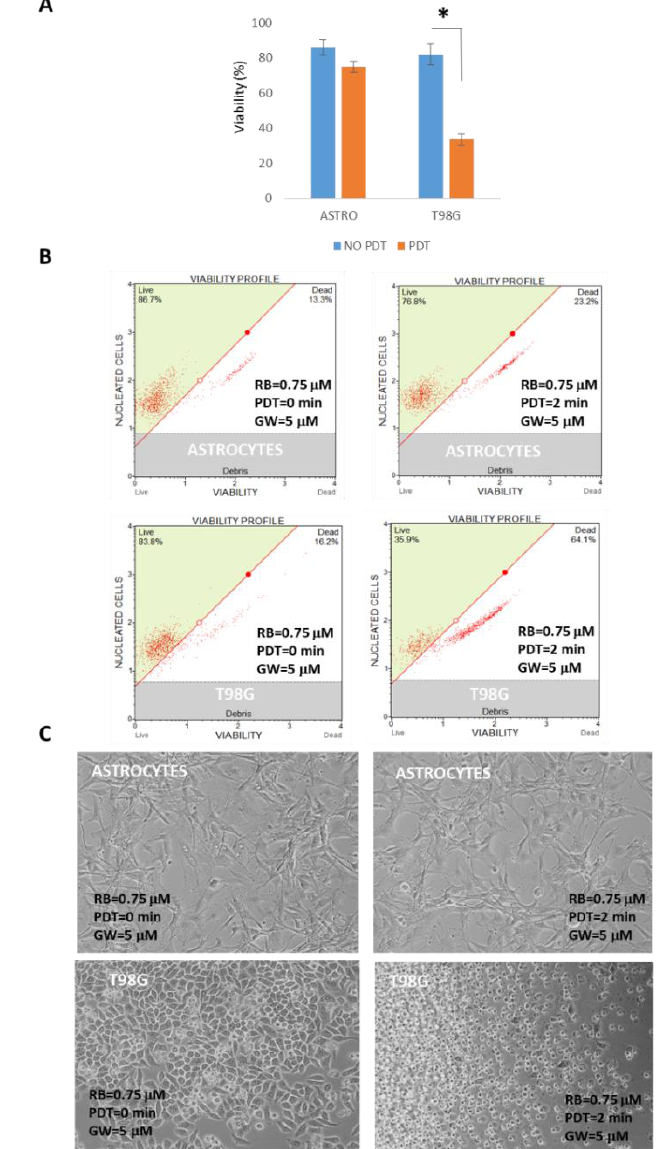
Figure 10. Viability assays comparison following RB starvation, PDT exposition and GW4869 ad- ministration in normal rat astrocytes and T98G cells. ( A ) Astrocytes and T98G cells were incubated with RB = 0.75 μ M for 30 min in HBSS starvation, which was followed by PDT exposition of 0 or 2 min at 562/576 nm, administration of GW4869 (GW = 5 μ M) in reconditioning standard media for 24 h. Asterisk indicated statistical significance compared to not PDT exposed cells ( p < 0.05, ANOVA one-way; SD are highlighted as vertical bars). Viability graphs and plots were obtained using Guava Muse Cell Count & Viability kit (Luminex) analyzing 2000 cells each of two independent experiments. ( B ) Examples of cytofluorimetric viability plots and ( C ) optical microscope examinations (Nikon Eclipse T100, magnification 10×) of astrocytes and T98G PDT-untreated and -treated cells at 24 h p.t.